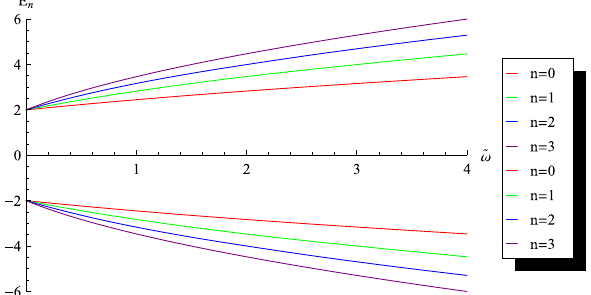
Fig. 1 Dependence of the total energy of a spinless composite system formed by a fermion-antifermion pair interacting via Dirac oscillator interaction ( ∝ ω ) in the presence of an external uniform magnetic field on the effective coupling strength ( ω ) that holds such a pair together. (cid:19) (cid:18) ,ω ω − ω c = | e | B 0 Here, ω = 4 and m = c = ¯ h = c mc 2